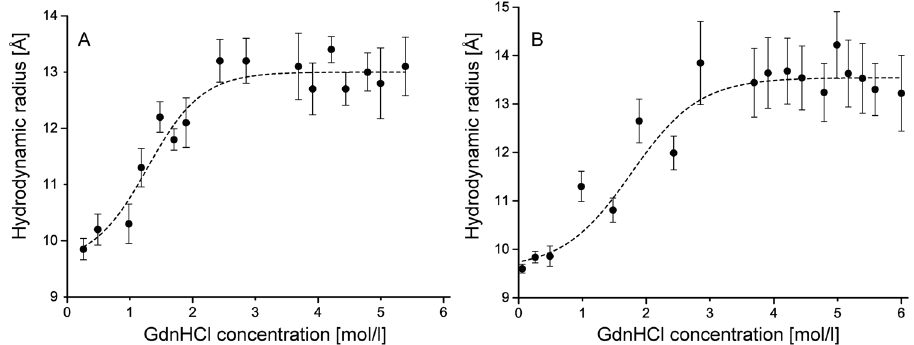
Figure 3. AF488-C(0)A β 42 unfolding curves as obtained by the analysis of a single 1fFCS measurement series ( A ) and as obtained by the analysis of a single 2fFCS measurement series ( B ). The dashed lines are best-fit lines to the two-state unfolding model (equation (1)). The hydrodynamic radius is plotted as a function of the GdnHCl concentration. The error bars of the unfolding curves were derived as the standard deviation of the fitting results of 10 correlation curves per data point.